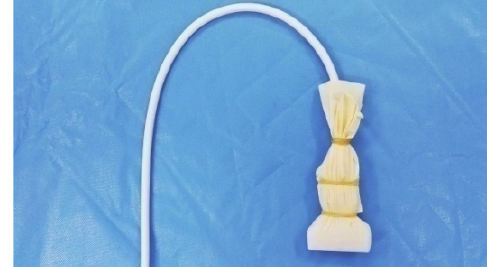
Figure 7 Ultrasonic probe wrapped by a sterilization